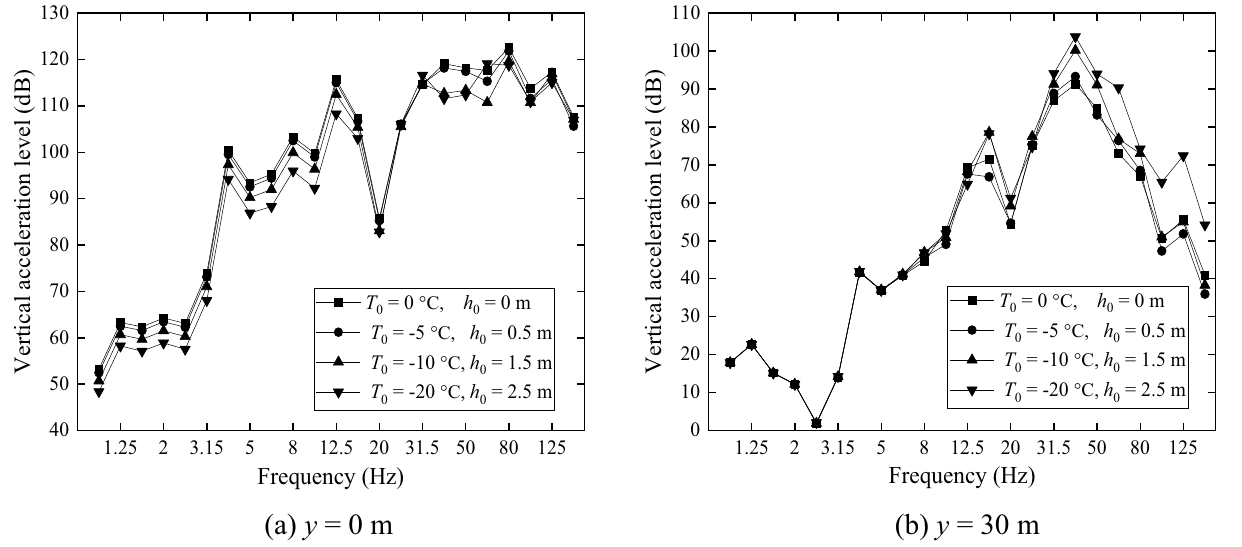
Figure 19. Ground vibration acceleration level in one-third octave bands at x = 0, ( a ) y = 0 m and ( b ) y = 30 m. Only the changes of ground parameters caused by freezing temperature is